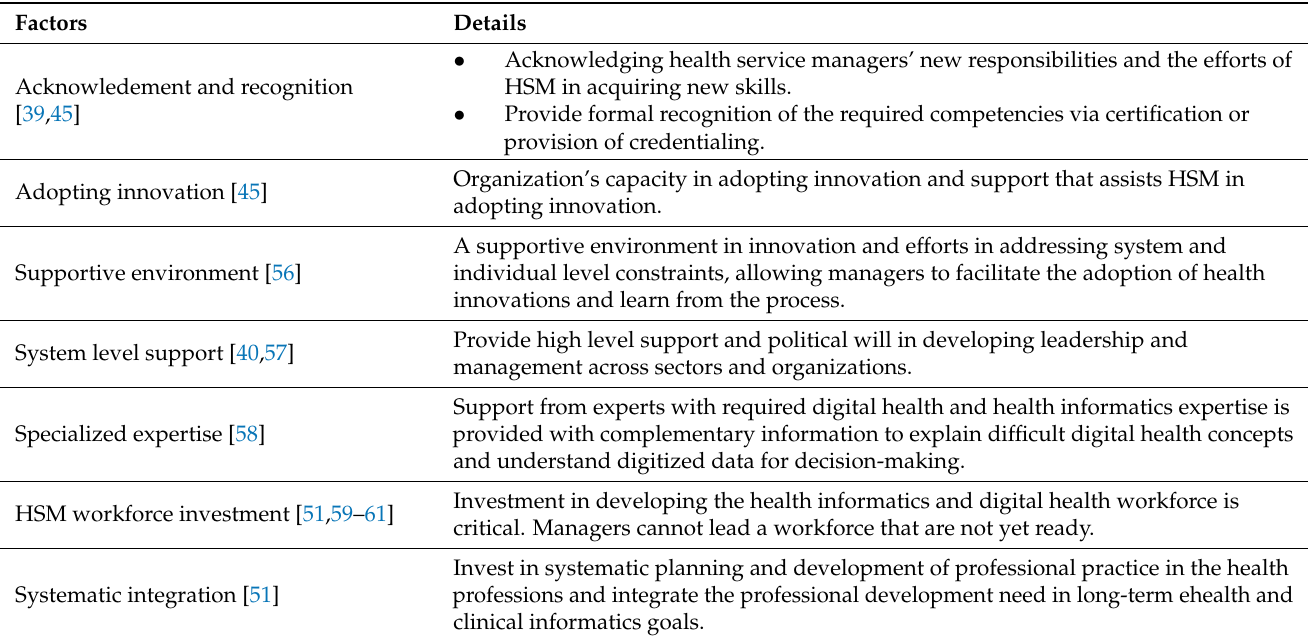
Table 2. Seven key factors that enable health management workforce